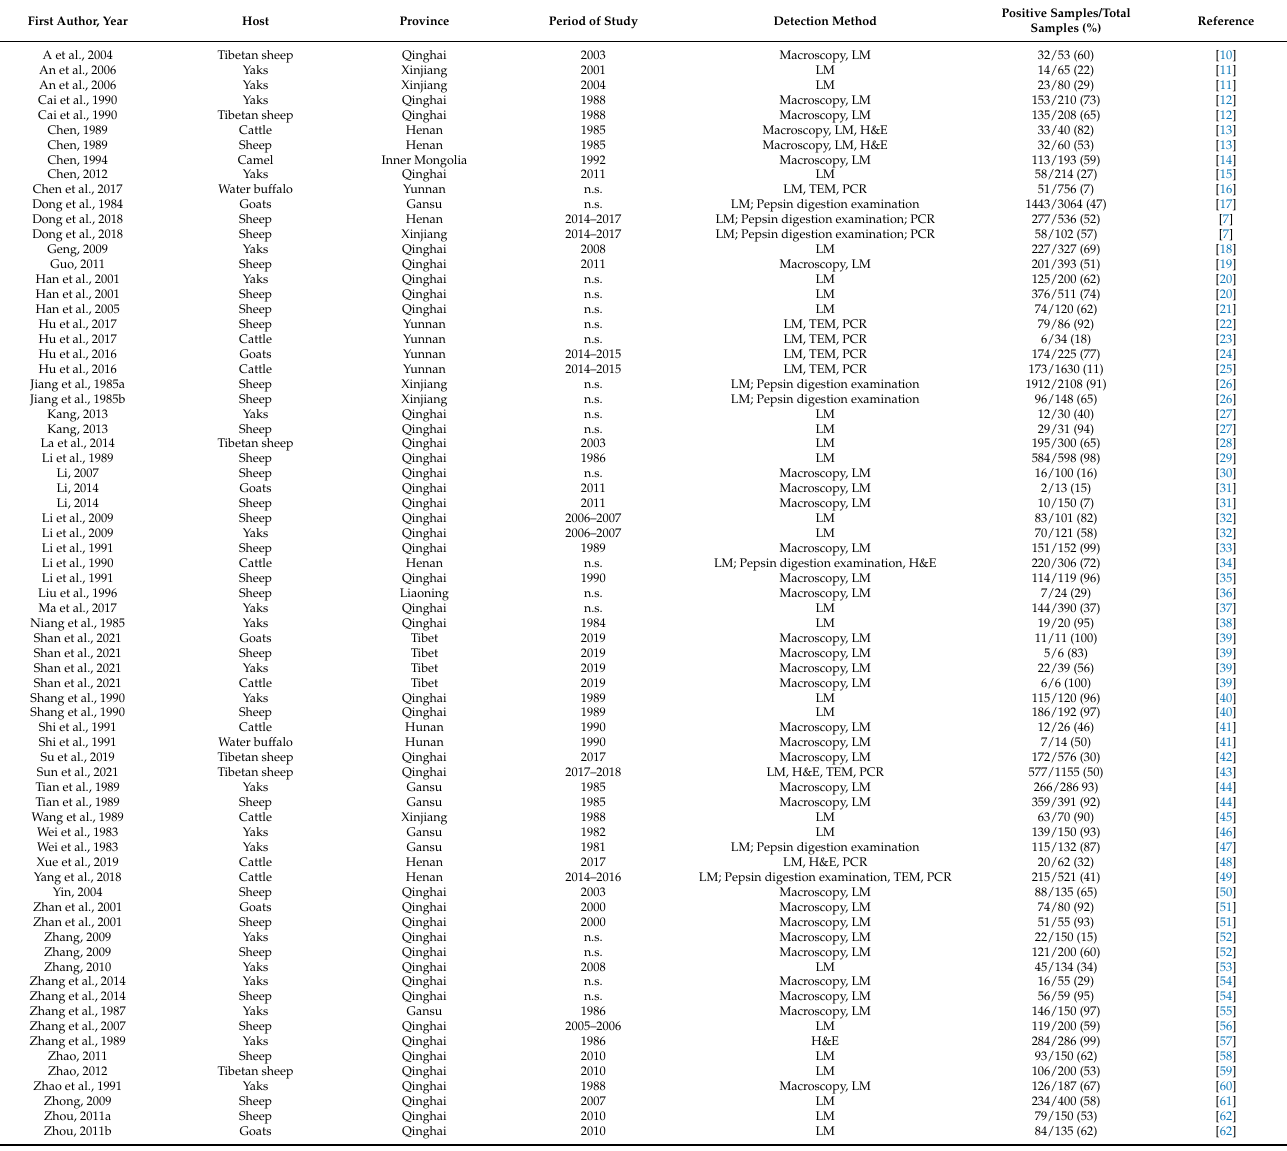
Table 1. Included studies of Sarcocystis infection in ruminants.